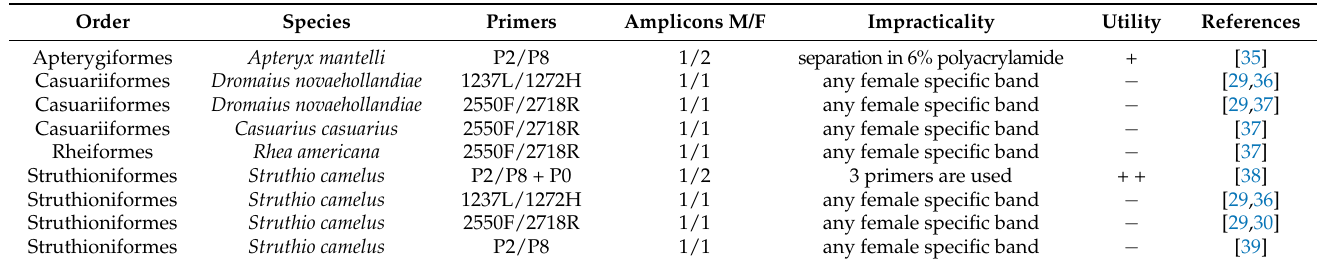
Table 1. Molecular markers based on the intron length polymorphism of the CHD1 gene used for sex determination in Palaeognathae